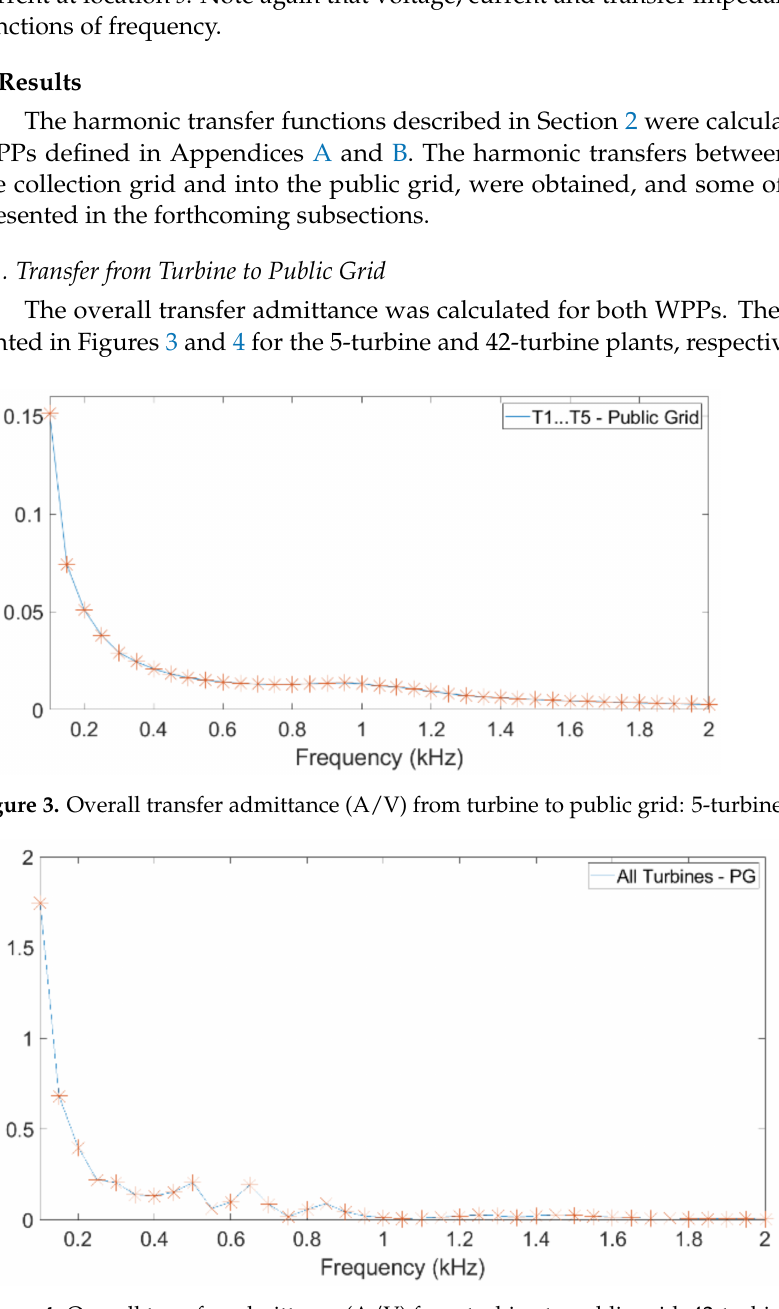
Figure 4. Overall transfer admittance (A/V) from turbine to public grid: 42-turbine